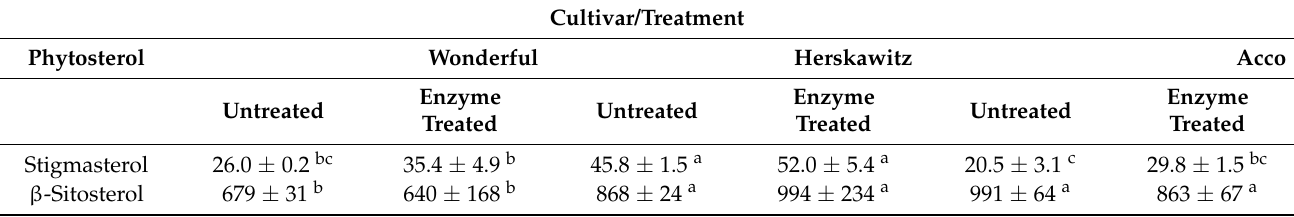
Means ± standard deviation of analysis ( n = 3). Different superscript letters in the same row indicate significant difference ( p < 0.05), according to Duncan’s multiple range